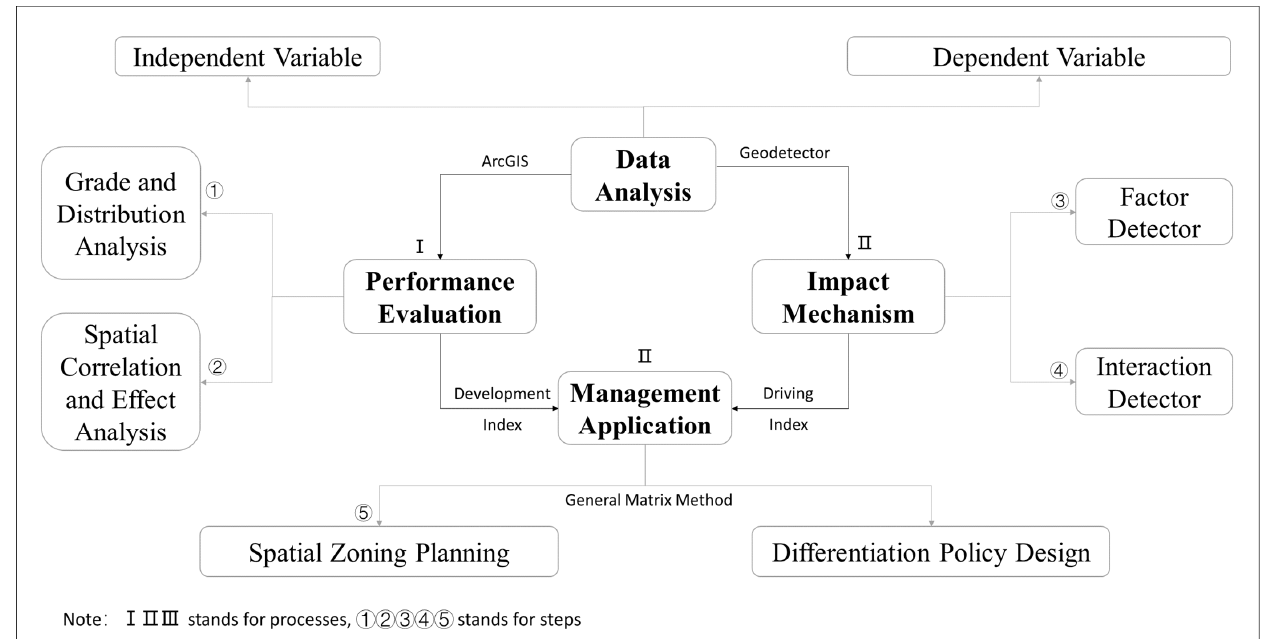
Figure 3. Research